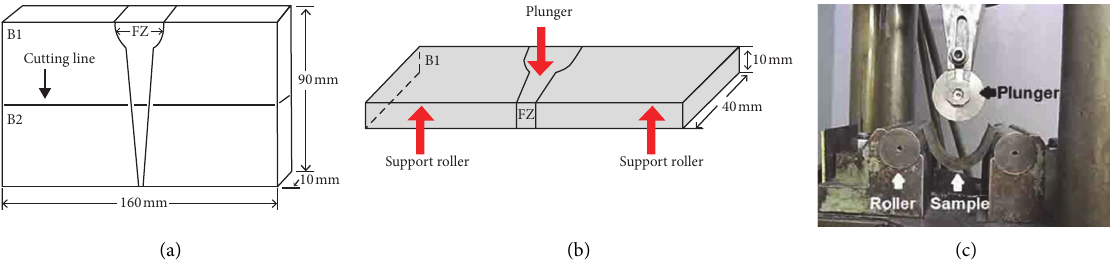
Figure 5: Three-point side bend test: (a) extraction of bend samples; (b) position of weld seam in the bend sample; (c) bend apparatus.